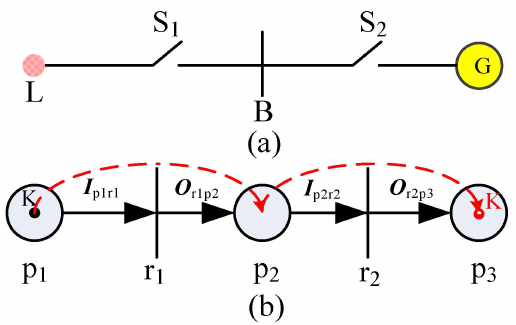
Figure 3. Petri net model for power analysis. ( a ) Simple power network. ( b ) Equivalent Petri net